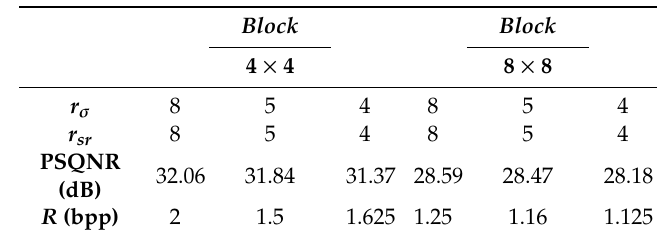
Table 1. Block truncation coding algorithm with the optimal binary quantizer ( y 2 = 1/ the monochrome image of Lena.